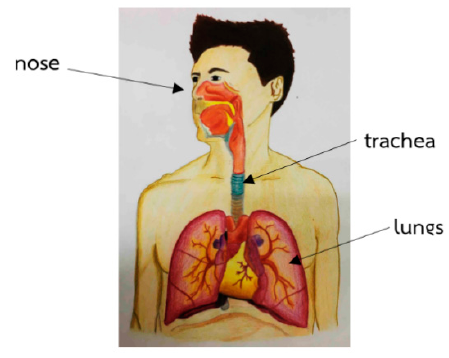
Figure 1. The human respiratory system.